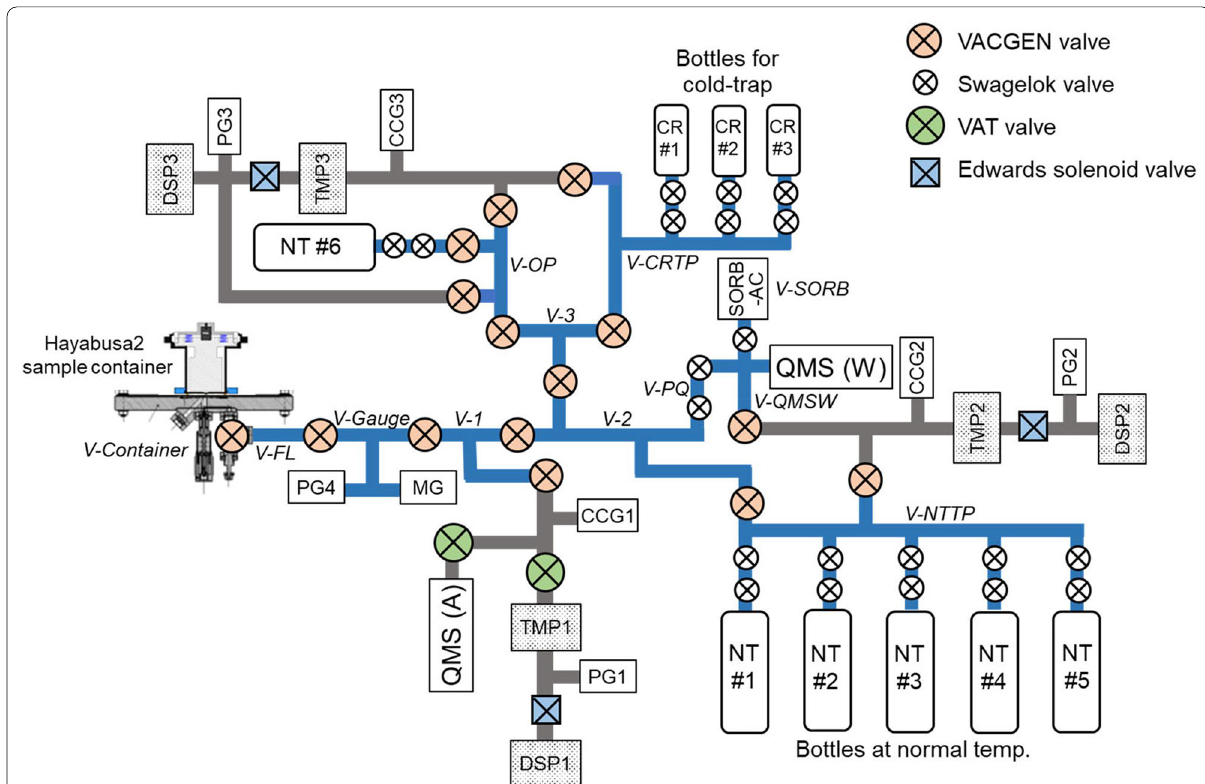
Fig. 4 Schematic drawing of the GAs Extraction and Analyses system (GAEA). Working volumes (areas used for gas expansion) are shown in blue and pumping lines are shown in gray. Each area between valves is named as labeled in italic. Abbreviation: QMS (W)—quadrupole mass spectrometer (Watmass), QMS (A)—quadrupole mass spectrometer (Anelva), SORB-AC–SORB-AC getter, CCG—cold cathode gauge, MG— miniature ion gauge, PG—Pirani gauge, TMP—turbo molecular pump, DSP—dry scroll